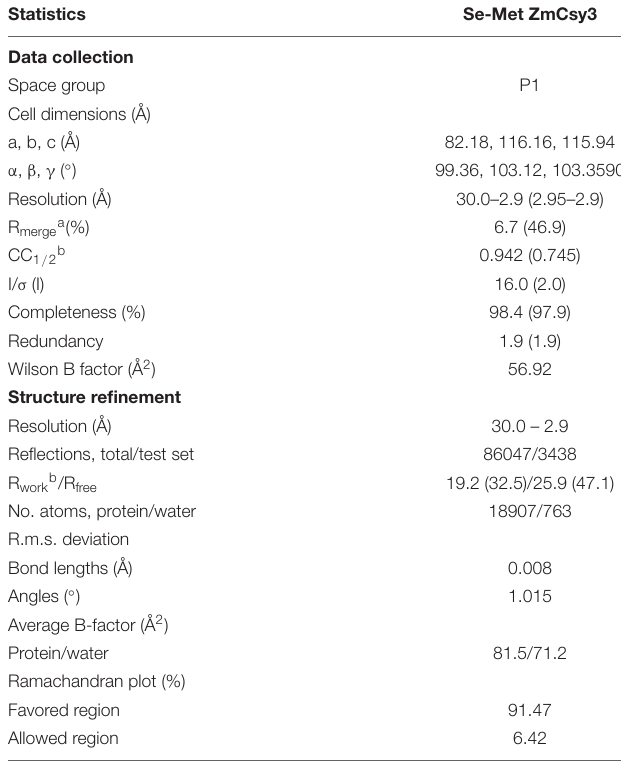
TABLE 1 | Data collection and refinement statistics for